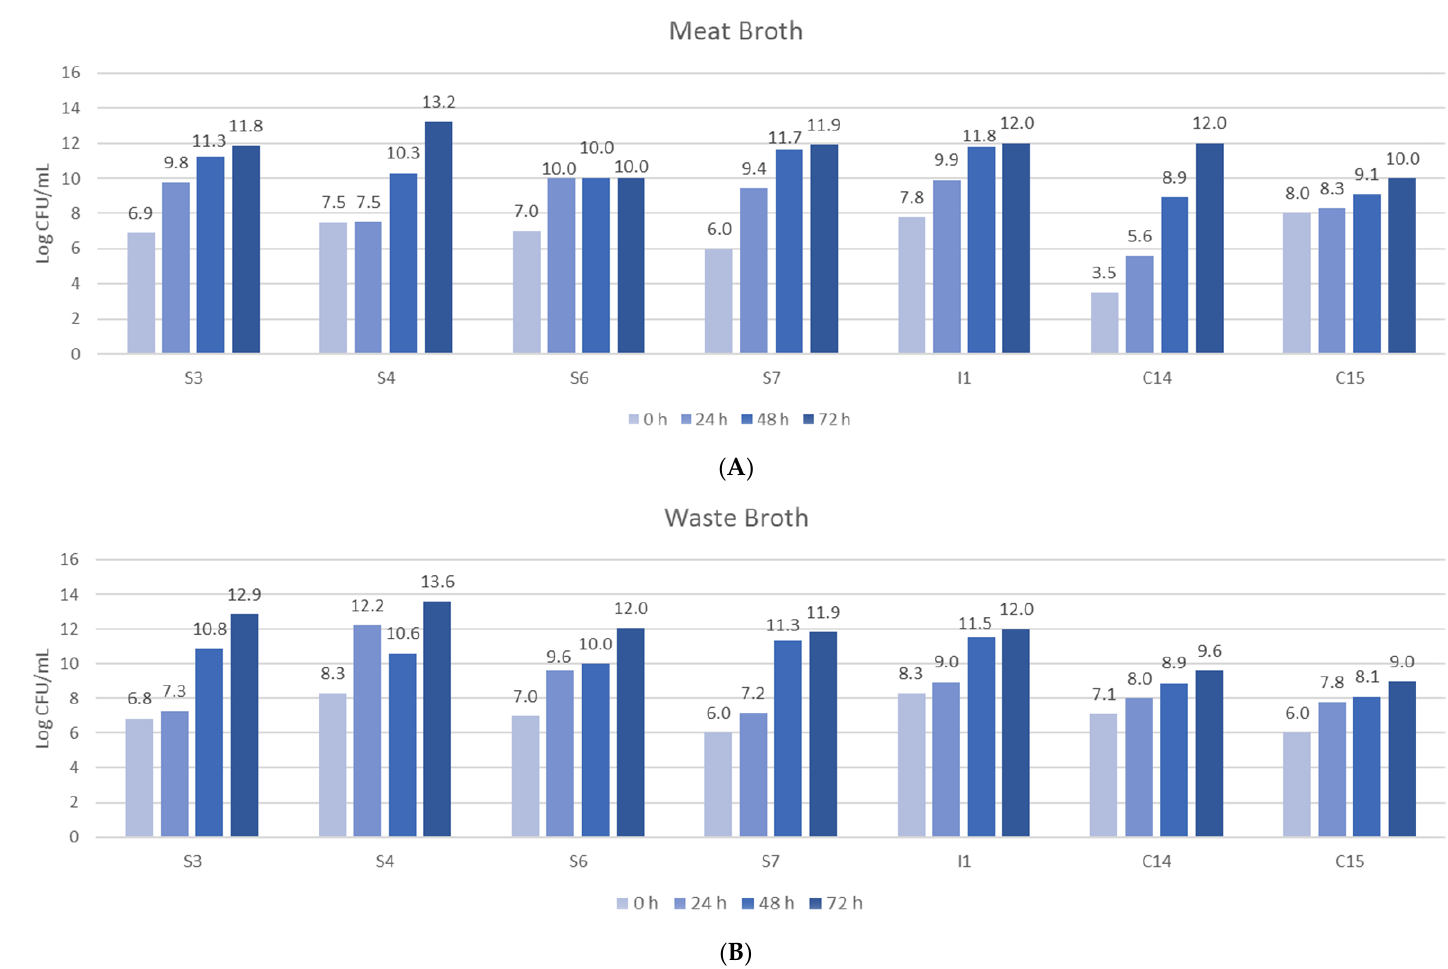
Figure 2. Bacterial growth in ( A ) meat broth (MB) and ( B ) by-products broth (WB) at three fermentation times (24, 48 and 72 h). S: Bacteria from stomach; I: Bacteria from small intestine; C: Bacteria from colon.